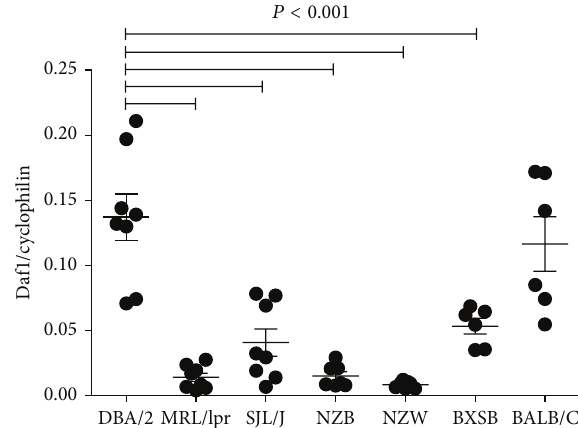
Figure 1: Daf1 mRNA is reduced in autoimmune prone mice. Real time PCR was used to determine Daf1 mRNA in spleen cells of na¨ıve female autoimmune prone MRL- 𝐹𝑎𝑠 𝑙𝑝𝑟 (MRL/lpr), NZB, NZW, and BXSB mice and healthy DBA/2 and BALB/c mice. Daf1 was expressed relative to cyclophilin A. 𝑁 = 4-5